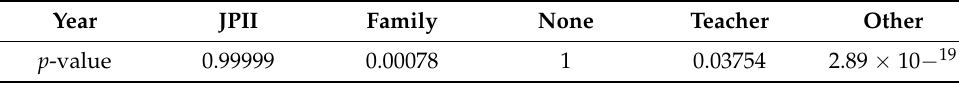
Table 3. Summary of prop.test: Alternative less.